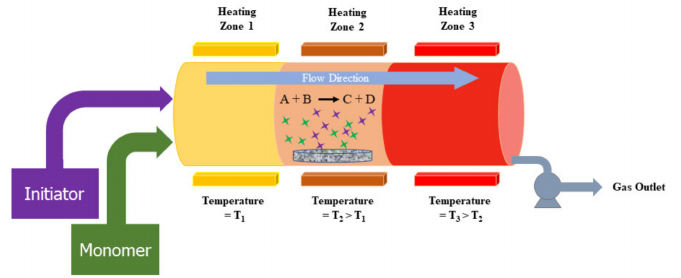
Figure 7. A three-zone chemical vapor deposition (CVD) system.